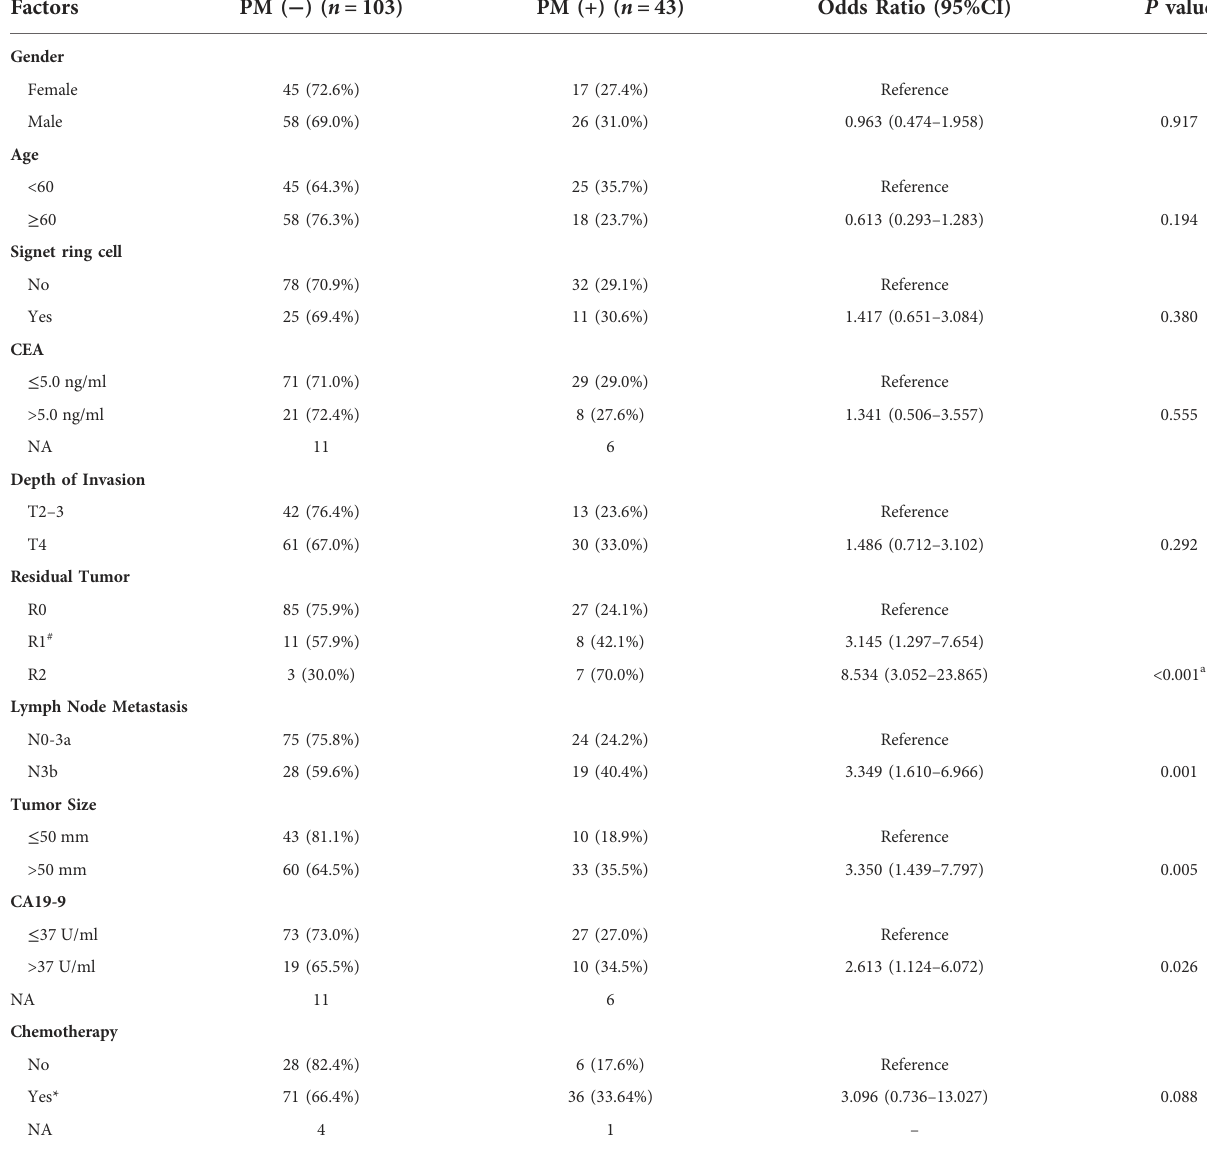
TABLE 2 Clinicopathological features between PM (+) and PM ( − ) patients with Borrmann type IV gastric cancer. Factors PM ( − ) ( n =